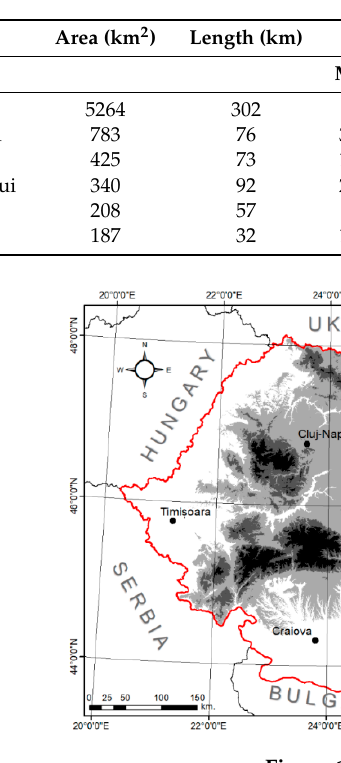
Table 1. General characteristics of the Buz ă u river catchment and its main sub ‐ catchments.